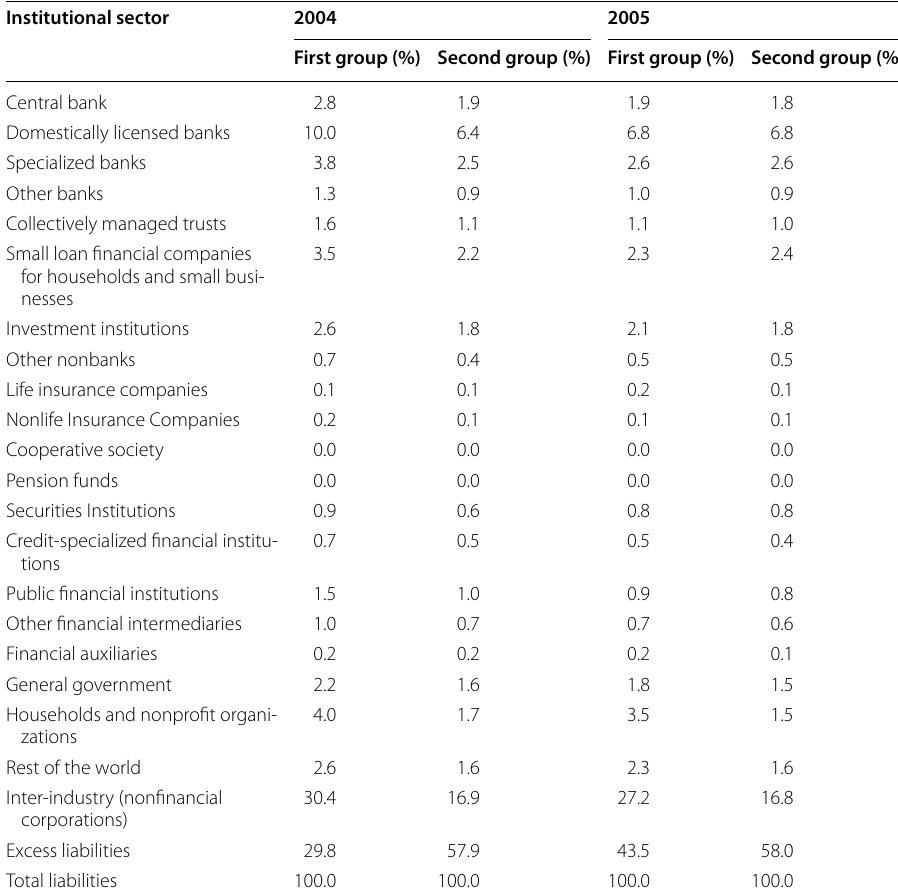
Table 15 Asset–total liabilities ratios of industries bifurcated into two groups Institutional